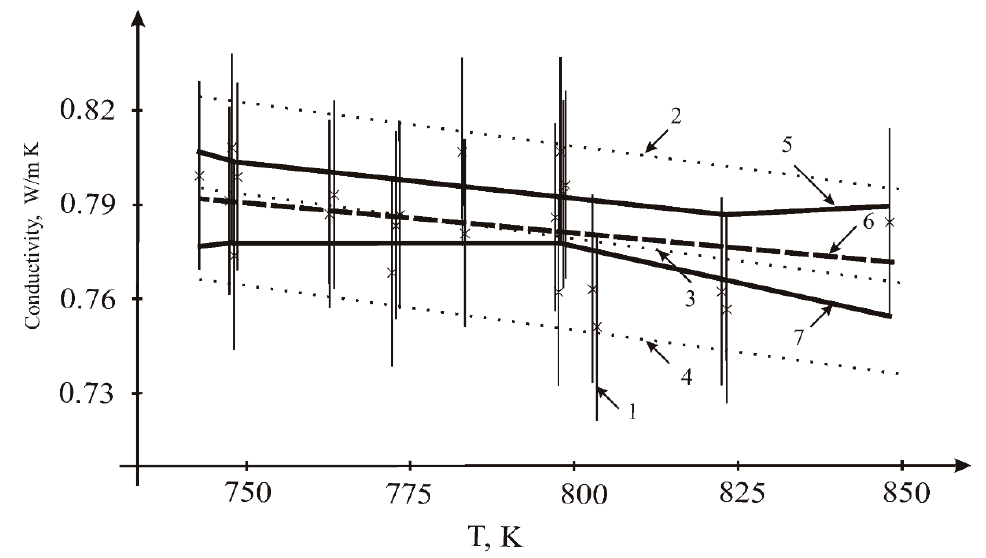
Figure 8. Fitting results for the thermal conductivity of the sample n = 22: 1—measurements ( × ) and their uncertainty intervals; 2, 4—the range of admissible values according to the LSQM ( ± 2 σ ); 3—the LSQM dependence; 5, 7—interval estimates of the upper and lower limits of admissible values of the dependencies; 6—interval estimation of linear dependence.